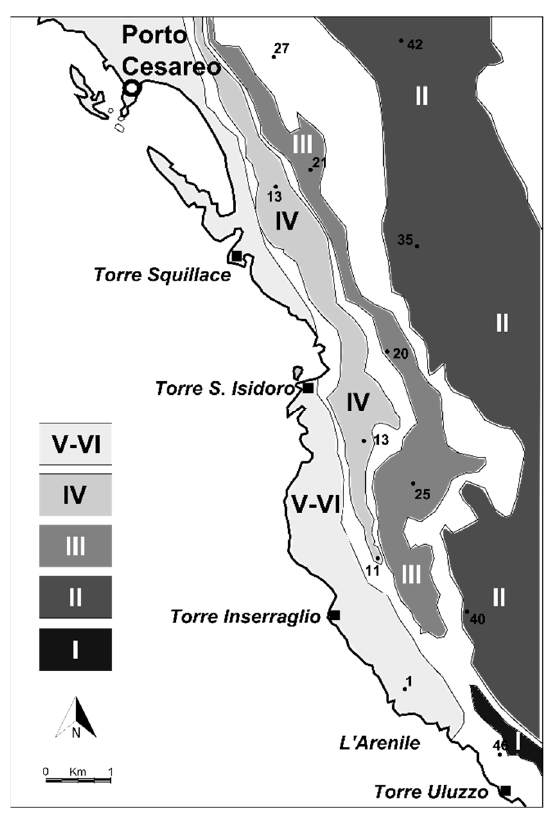
Figure 4. The coastal area stretching from Porto Cesareo to the L’Arenile site is marked by a staircase of marine terraces stretching between 40 m of altitude and mean sea level. The lower terrace is a polycyclic, rocky coastal platform shaped during the last 330 ka and placed between 3 m above m.s.l. and 1 m below m.s.l.